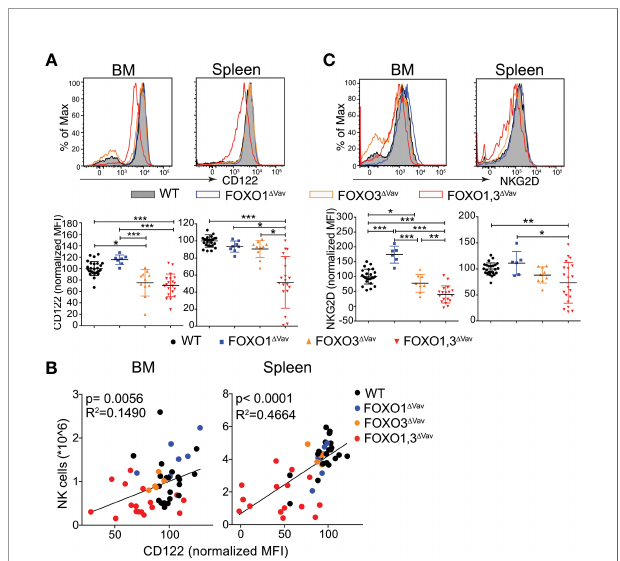
FIGURE 3 | FOXO regulates CD122 expression on NK cells. (A) Representative fl ow cytometry pro fi les (top) and normalized MFI (bottom panel) showing CD122 expression on BM and splenic NK cells (n = 8-28). (B) Correlation between CD122 expression and NK cell numbers (n = 50). (C) Representative fl ow cytometry pro fi les (top) and normalized MFI (bottom panel) showing NKG2D expression on BM and splenic NK cells (n = 6-26). In panels (A – C) : dots represent individual analyzed animals; bars indicate mean and SD; *, ** and *** indicates p-values <0.05, <0.01 and <0.001 respectively. P-values were calculated using: Kruskal Wallis tests with Dunn ’ s multiple comparisons test (panels A, C ) and linear regression (panel B